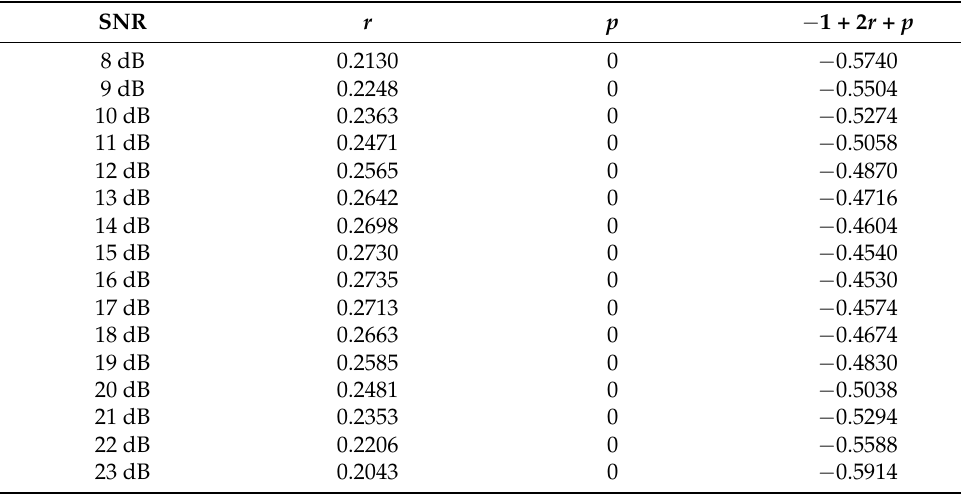
Figure 12. Output values of the trellis diagram converted into number axis. Table 1. Effect of r and p coefficient for two-way GPR target.